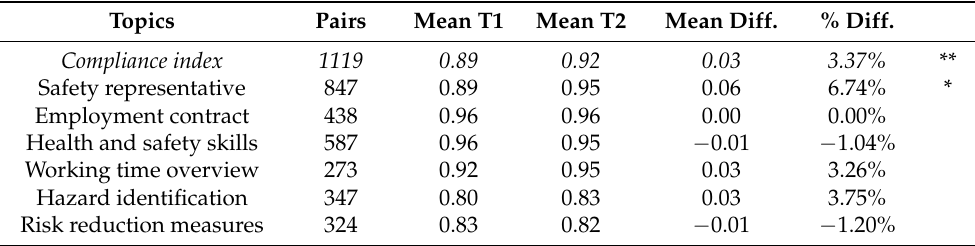
Table 5. Scores for compliance index and checkpoints for companies with OSH training at both T1 and T2 (study 2). Including paired samples t -test of mean difference.